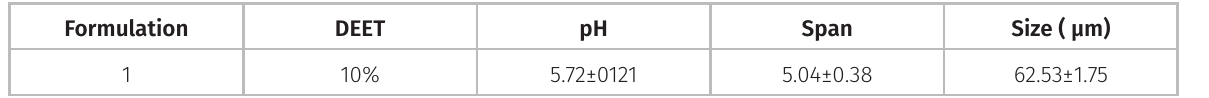
Table II. Results of polydispersion (Span) and Size of Solid Lipid Microparticles. Formulation